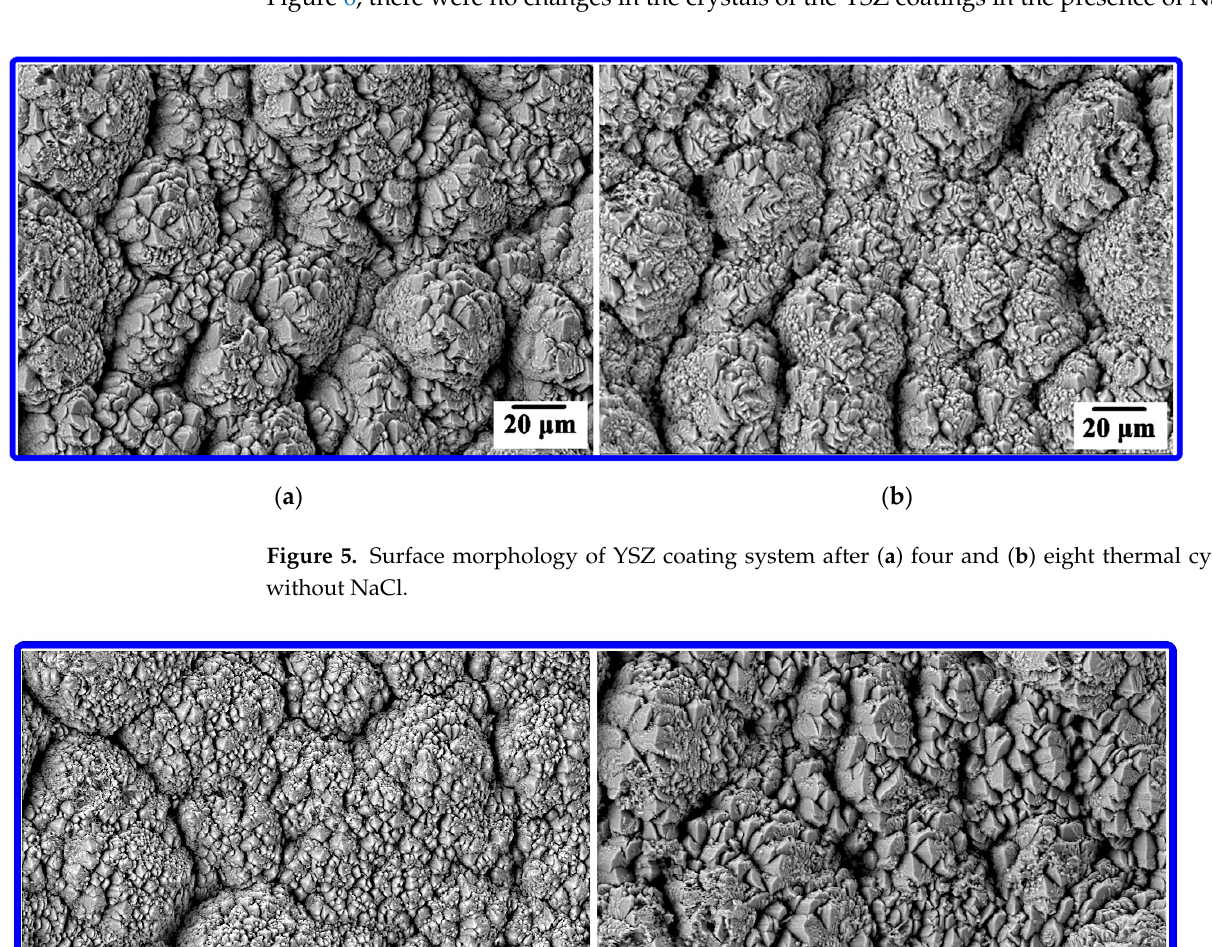
Figure 4. Selected visual images showing the top surface of YSZ coating after different numbers of corrosion test cycles. 1–14 represents the number of corrosion cycles. The salt-corroded region is approximately marked using a black dashed line.